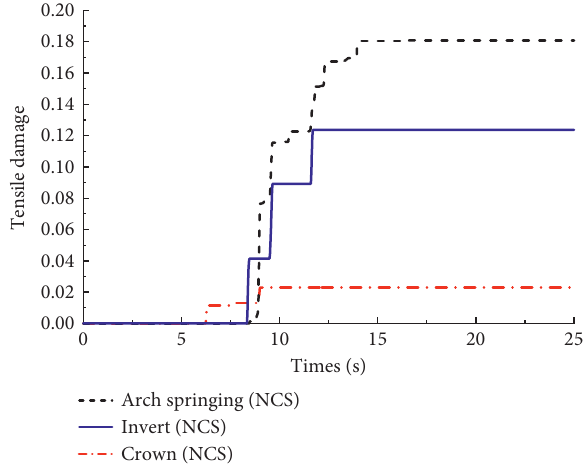
Figure 11: Damage time history curve of typical point of the lining section.